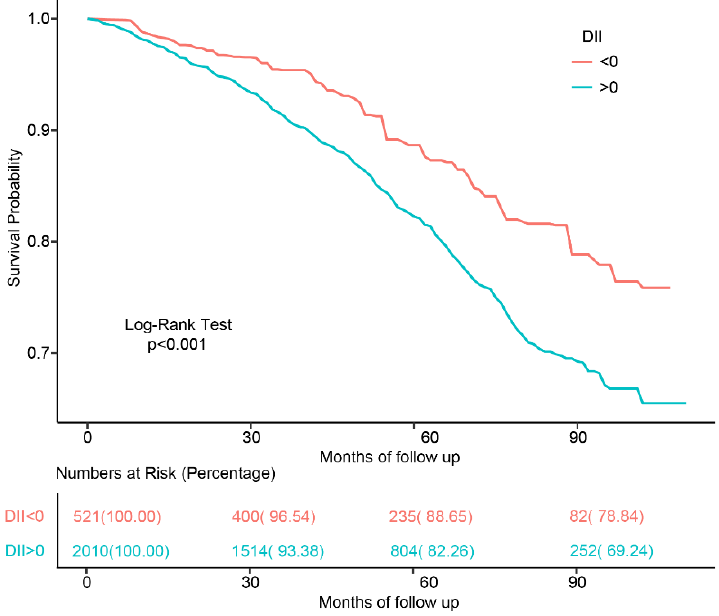
Figure 2. The Kaplan–Meier curve for the study population with different diets.